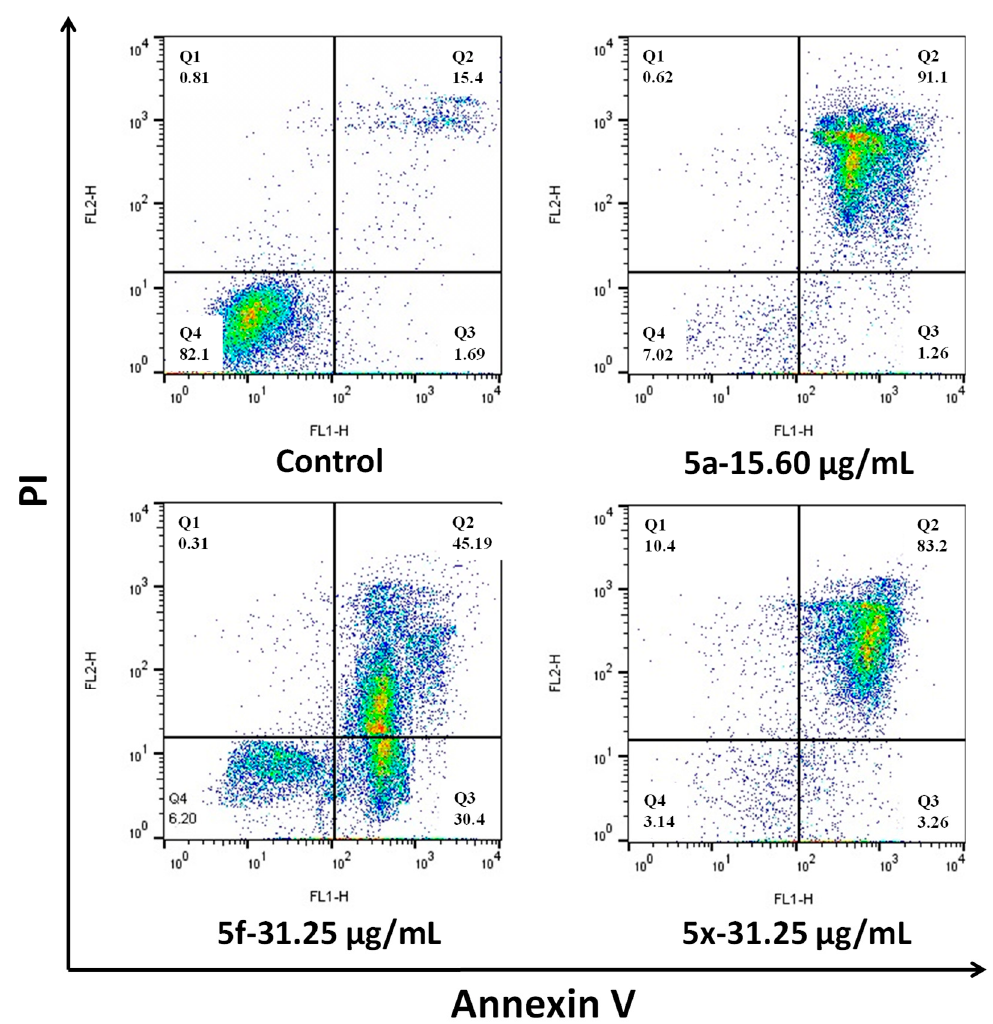
Figure 5. ApoptosisevaluationwasperformedbyAnnexinV-FITC / PI(AnnexinV-Fluoresceinisothiocyanate / Figure 5. Apoptosis evaluation was performed by Annexin V-FITC/PI (Annexin V-Fluorescein Propidium Iodide (FITC / PI)) double staining isothiocyanate/Propidium Iodide (FITC/PI)) double staining assay.